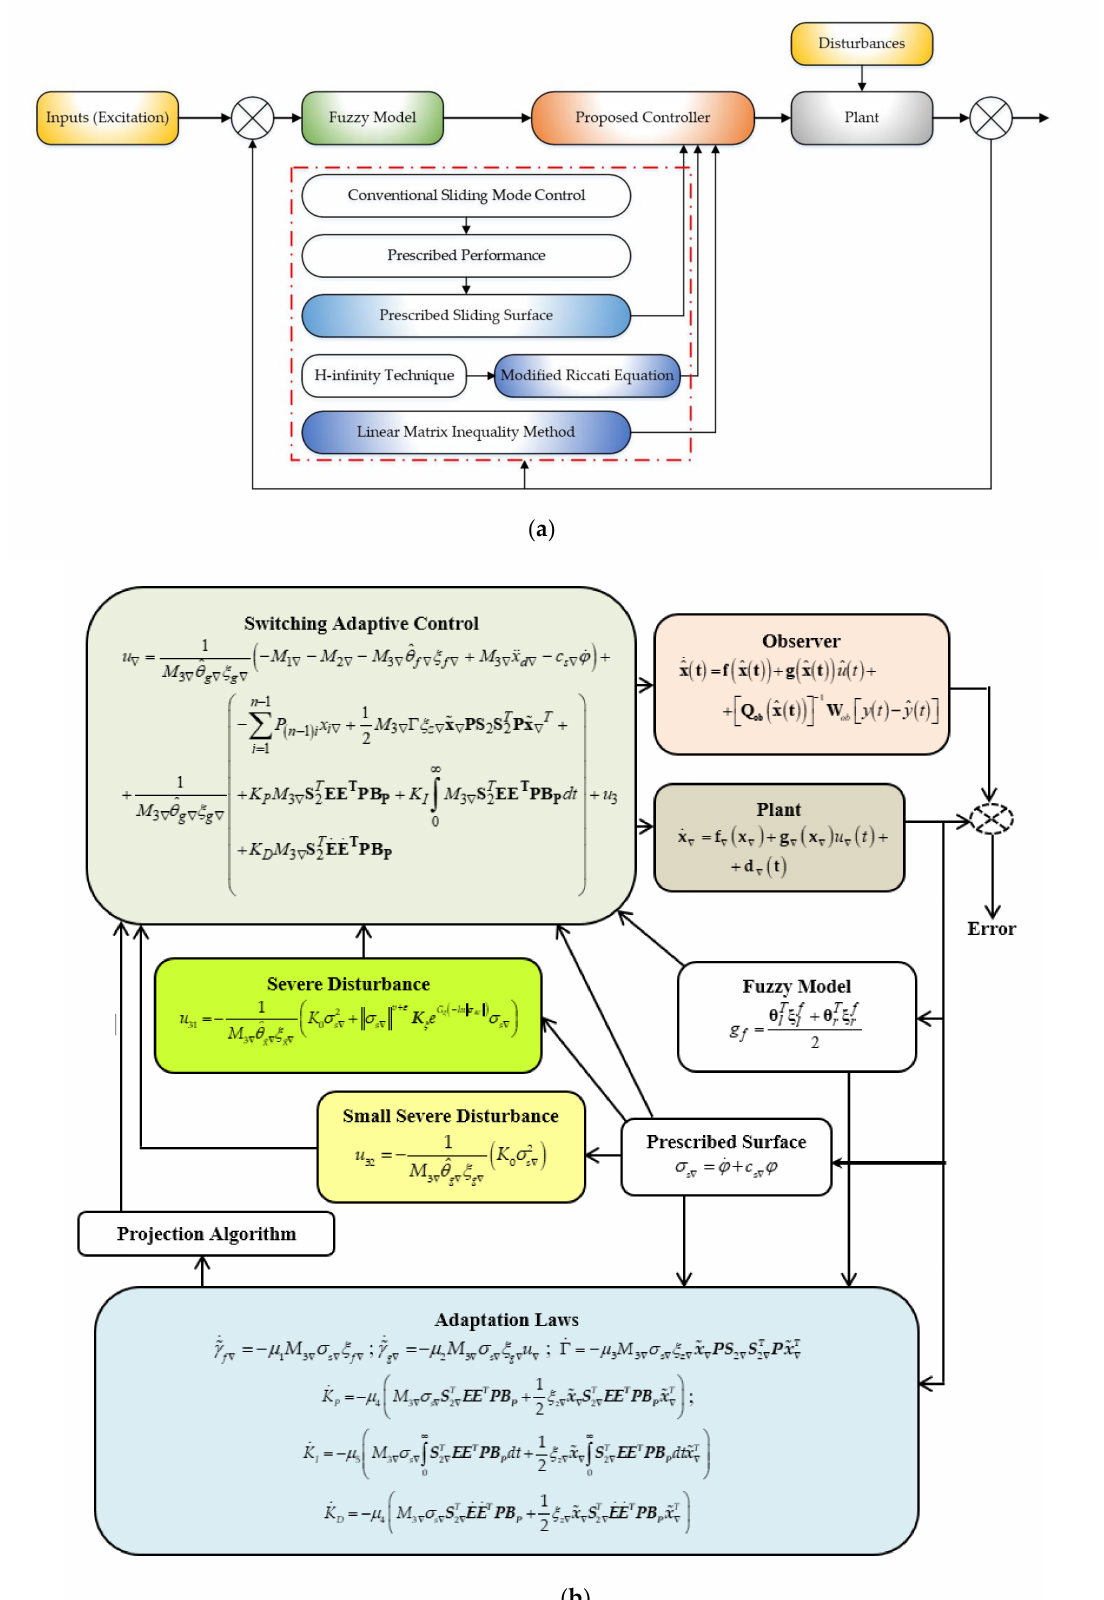
Figure 1. Control strategy of the proposed controller: ( a ) block diagram, ( b ) control